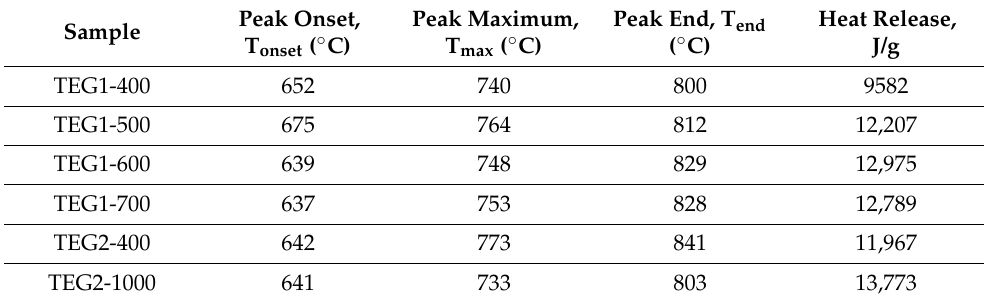
Table 5. Analysis of DSC peak of oxidation of EG samples.